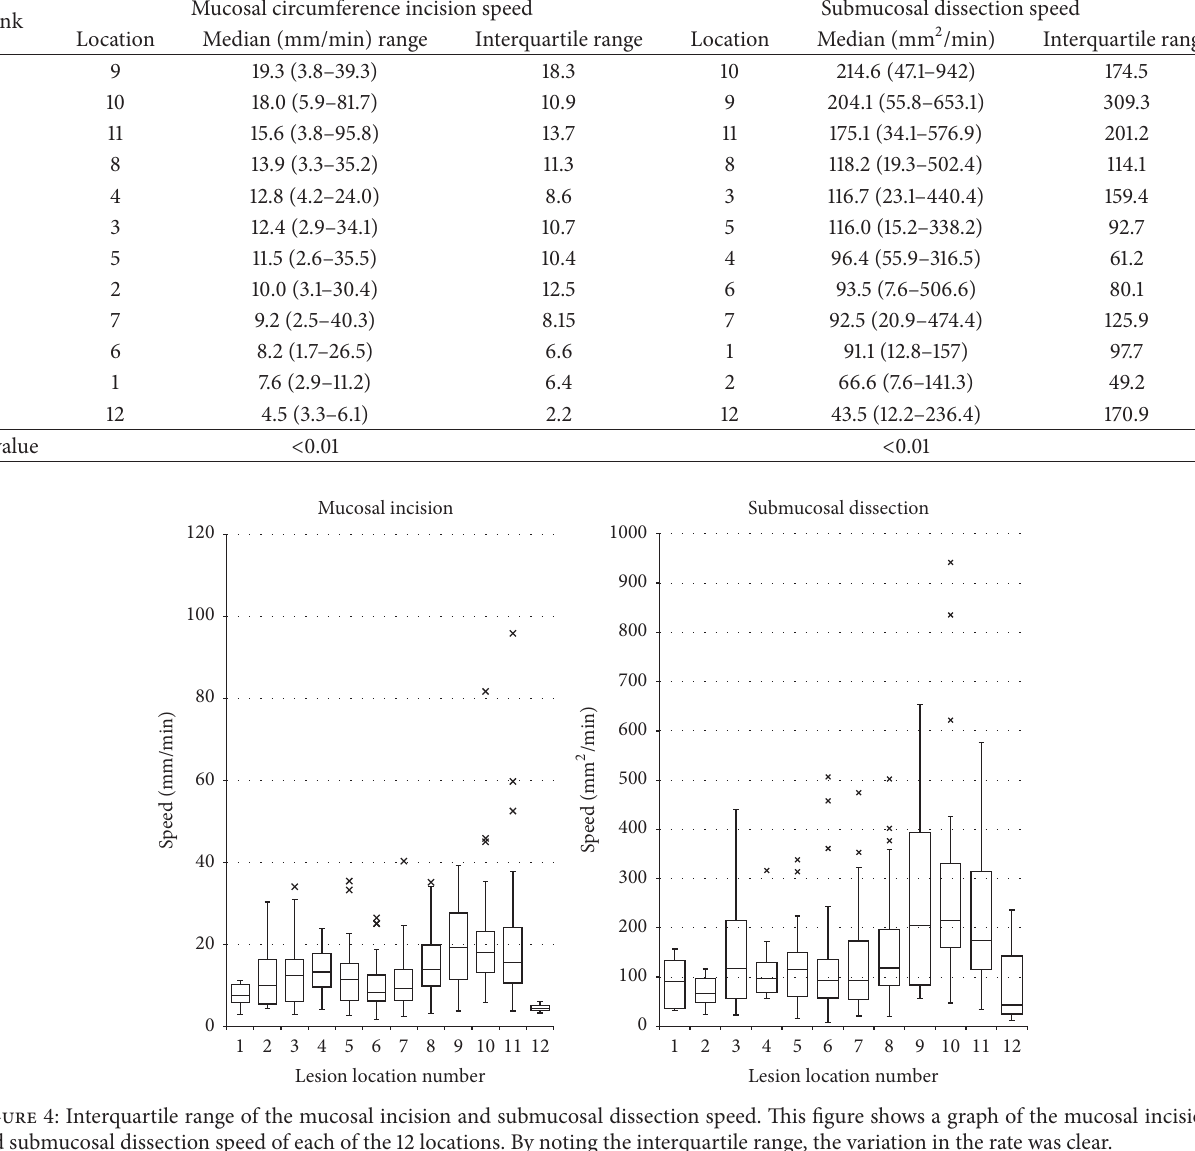
Table 4: Mucosal circumference incision speed and submucosal dissection speed cut (speed per minute) in descending order.